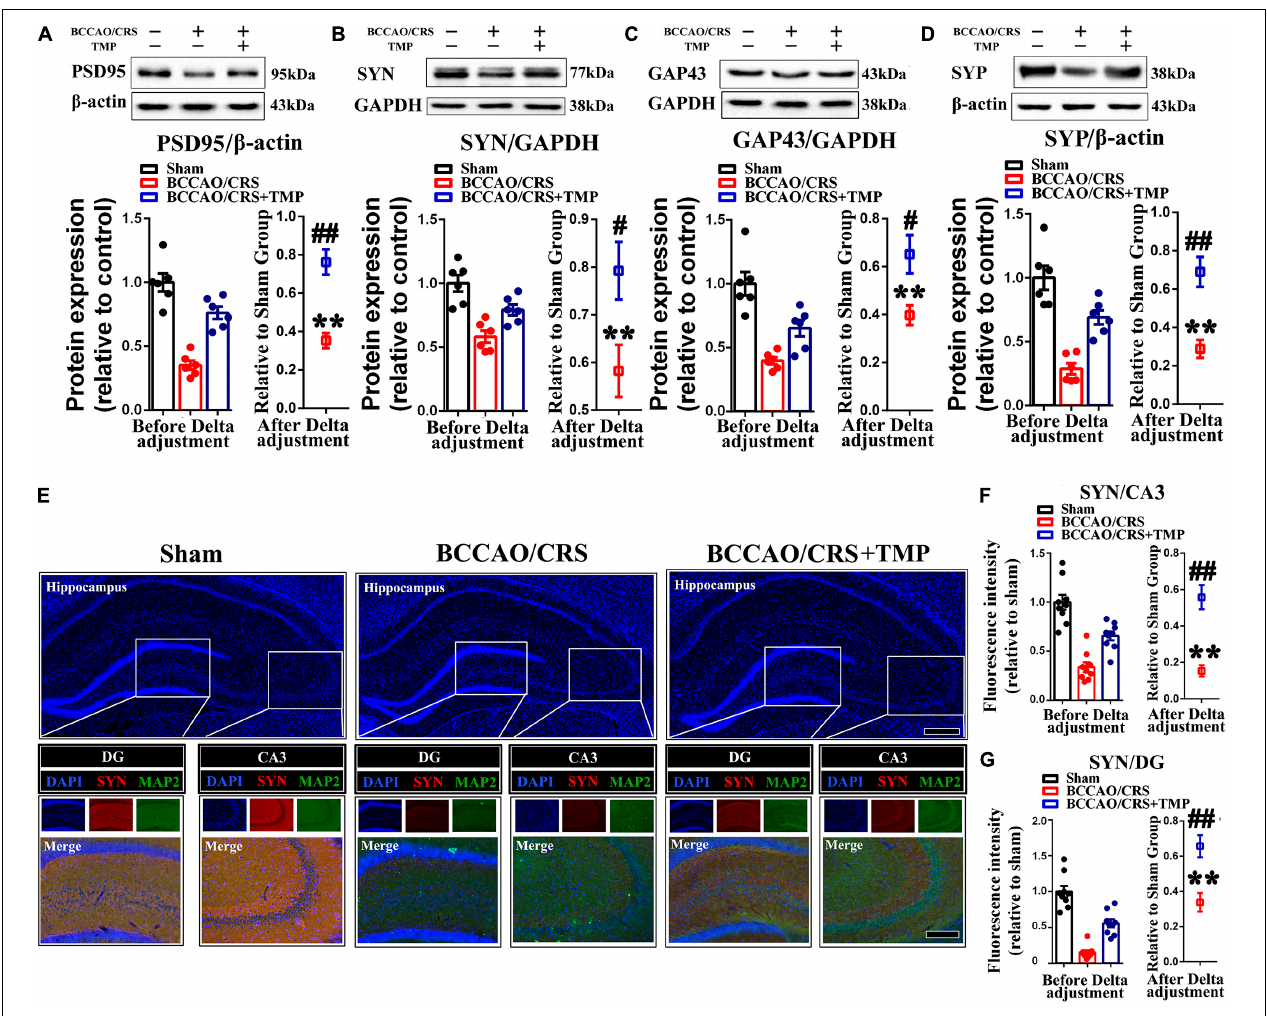
FIGURE 7 | TMP increases synapse-associated protein expression in BCCAO/CRS rats. (A–D) Representative immunoblots representing the expression and semi-quantitative analysis of synapse-associated proteins including PSD-95 (A) , SYN (B) , GAP-43 (C) , and SYP (D) . (E) Representative immunostaining showing the colocalization of MAP (green) and SYN (red) in the hippocampus of CA3 and DG. The inserts were high magnification from each group. Nuclei were counterstained with DAPI. Scale bar: Scale bar: 400 µ m; and 200 µ m for enlarged inserts. (F) Quantification of the fluorescence intensity of SYN in hippocampal CA3. (G) Bar graph summarizing the fluorescence intensity of SYN in hippocampal DG. ** P < 0.01 vs. Sham. # P < 0.05, ## P < 0.01 vs. BCCAO/CRS. Data are presented as mean ± SE. n = 6 per group for Western blotting; n = 3 in each group and 3 slices per rat for immunofluorescence.